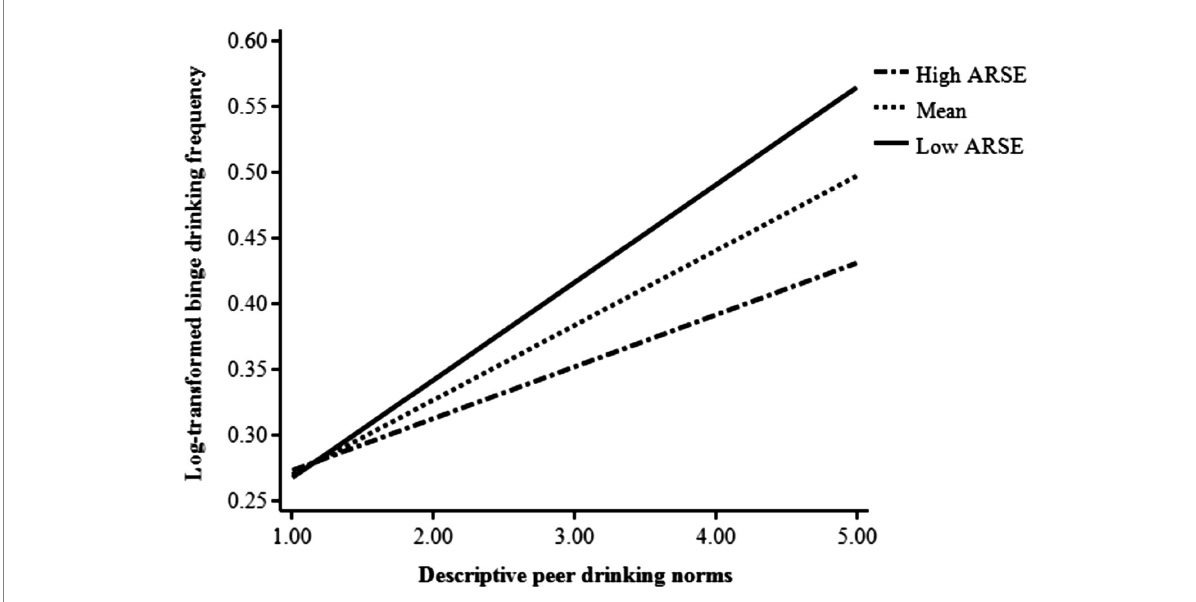
FIGURE 2 Alcohol resistance self-efficacy (ARSE) moderated the effects of descriptive peer drinking norms on binge drinking